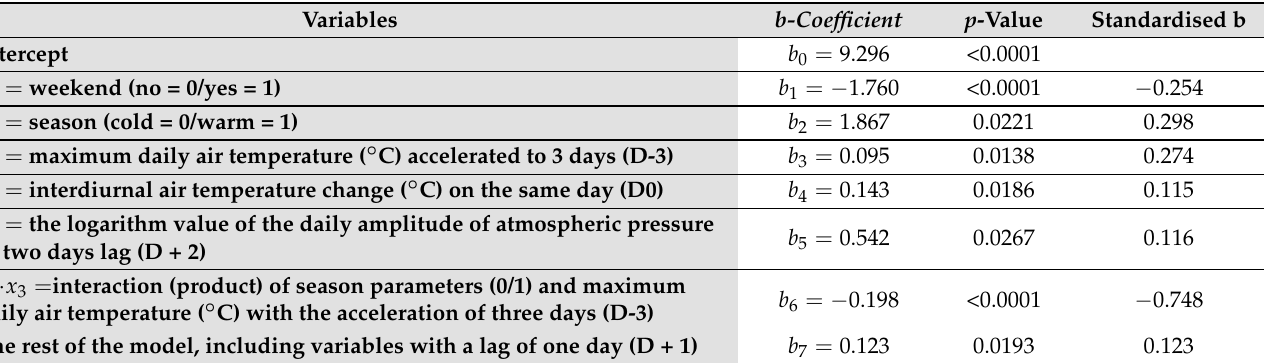
Table 6. Raw and standardised coefficients were obtained for the final regression model, together with an assessment of the significance of individual